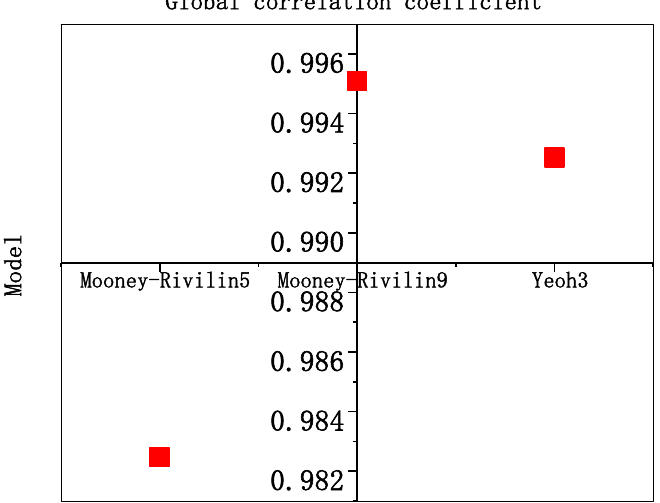
Figure 3. Global correlation coefficient fitting diagram.